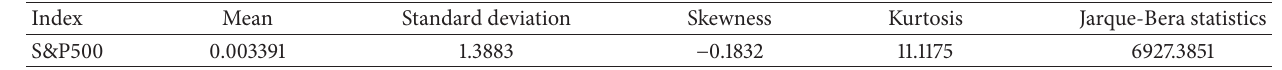
Table 4: Descriptive statistics for S&P500.